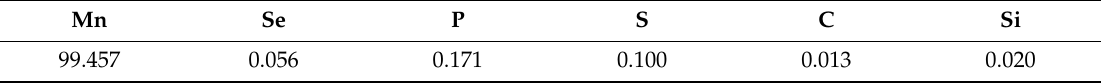
Table 1. Compositions of the rejected electrolytic manganese metal, wt%.